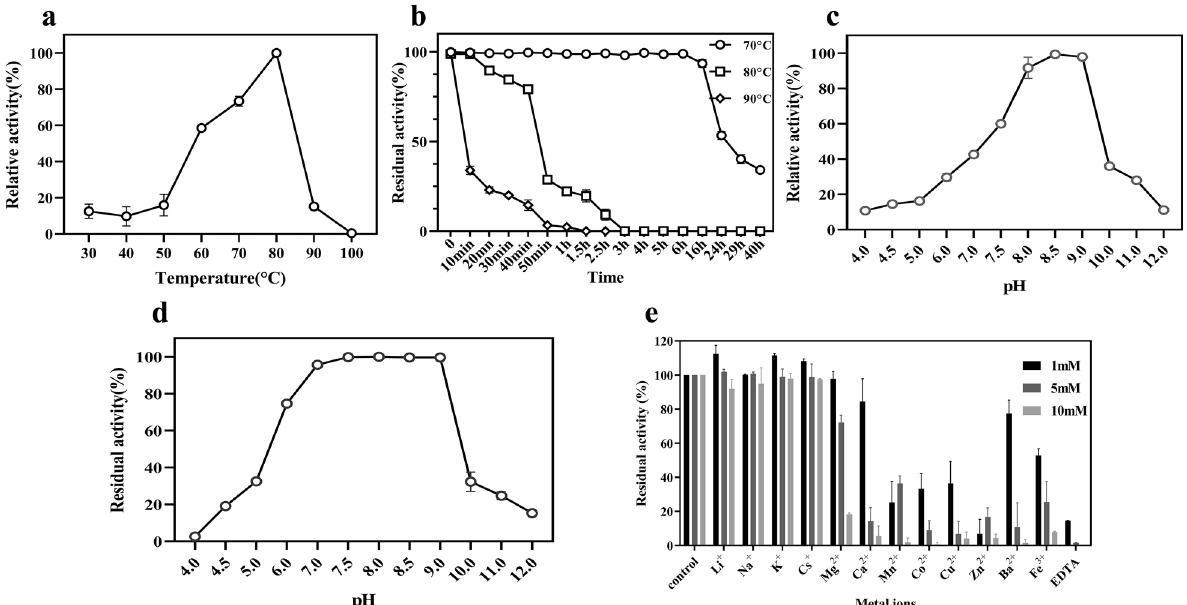
Fig. 3 Characterization of bl-GBE. The maximum enzyme activity in each group was set at 100%, a bl-GBE activity at different temperatures. Reactions were performed at temperatures ranging from 30 to 100 °C, b bl-GBE residual activity after incubation for different durations at 70 °C, 80 °C, and 90 °C, c Effect of pH on bl-GBE activity. Activity assays for purified recombinant bl-GBE were performed at 80 °C temperature with pH ranging from 4.0 to 12.0, d pH stability of bl-GBE. bl-GBE was preincubated for 12 h at pH ranging from 4.0 to 12.0 before measuring residual activity,